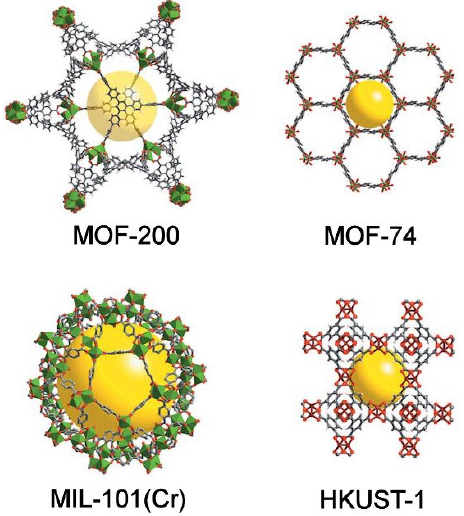
Figure 13. Representative types of MOF structures which exhibit high gas storage properties. MOF-200: H 2 ; MOF-74: CO 2 , NO, CH 4 ; MIL-101(Cr): H 2 , CO 2 ; HKUST-1: CO 2 , NO, CH 4 .